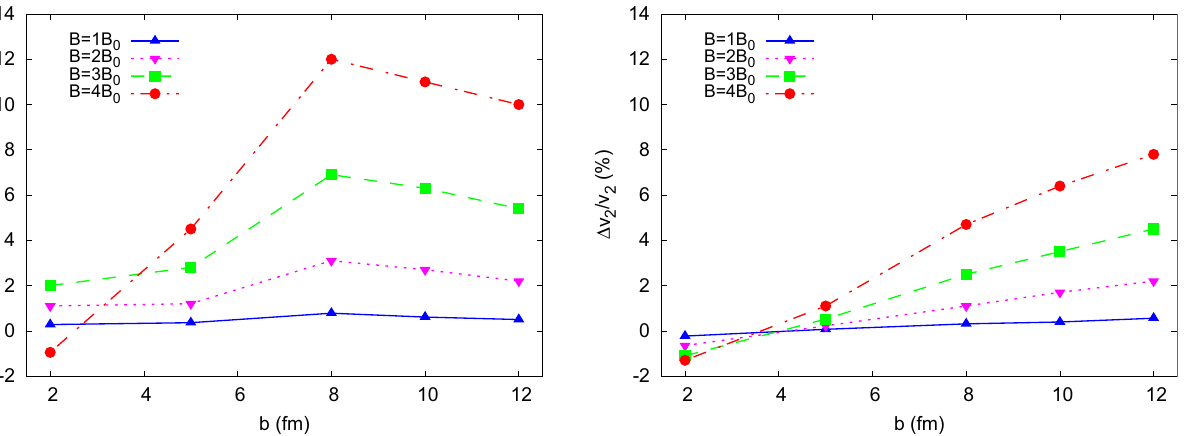
Fig. 3 Percentage of enhancement of v 2 ( y = 0 , p T (cid:8) 3GeV ) com- pared with the case without magnetic field, (v 2 ( B ) − v 2 ( 0 ))/v 2 ( 0 ) · 100, with respect to the impact parameter b . The different lines correspond